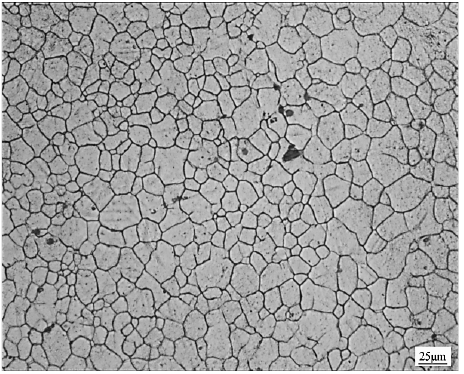
Figure 8. The metallography of the AZ31B magnesium alloy sheet at 25 °C.